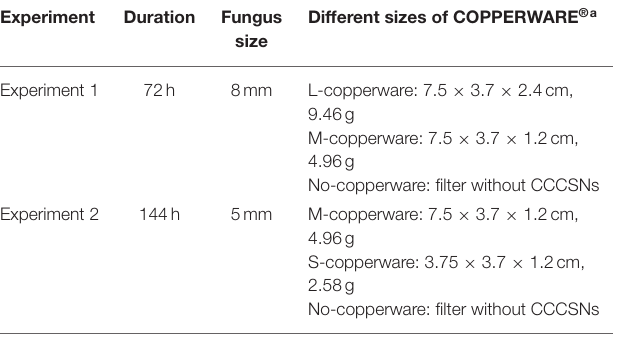
TABLE 1 | Description of the parameters used in the COPPERWARE ® filtration experiments (experiment 1 and experiment 2).